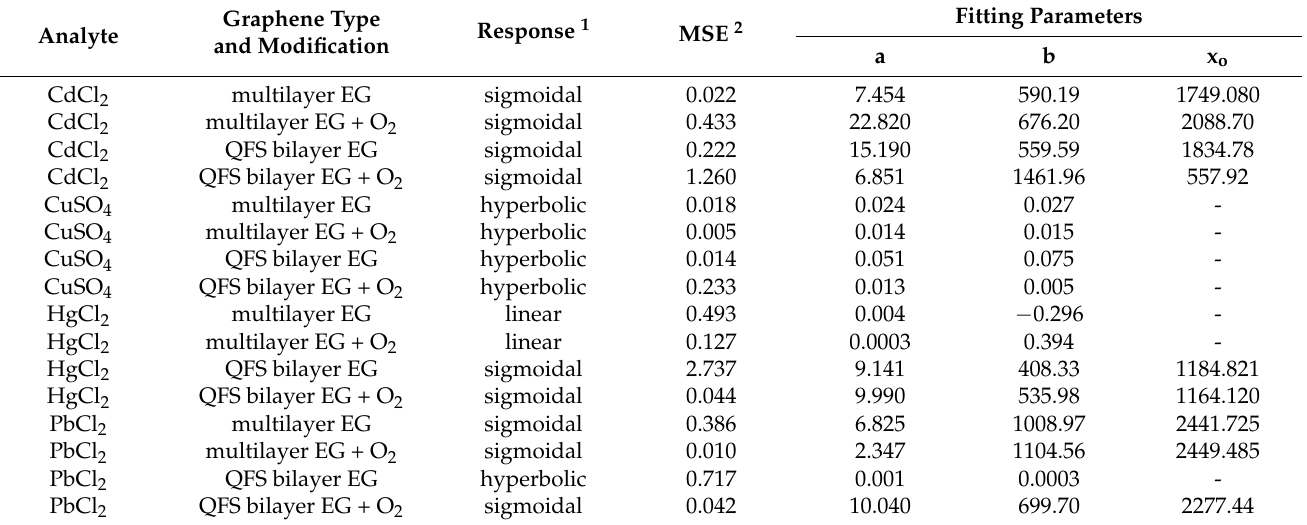
Table 1. Fitting parameters of the dose–response for each analyte.